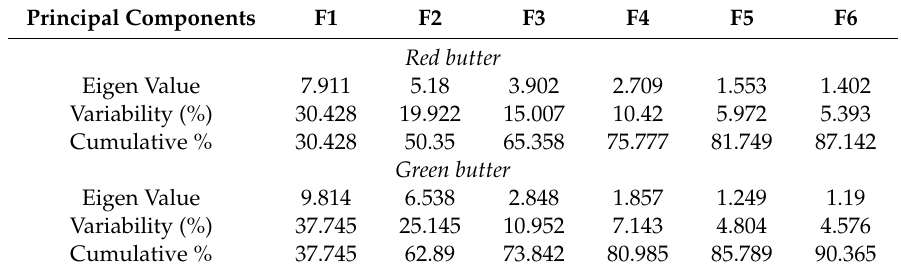
Table 6. Eigen value, factor scores, and contribution of the first six principal component axes to variation in lettuce under di ff erent end-of-day